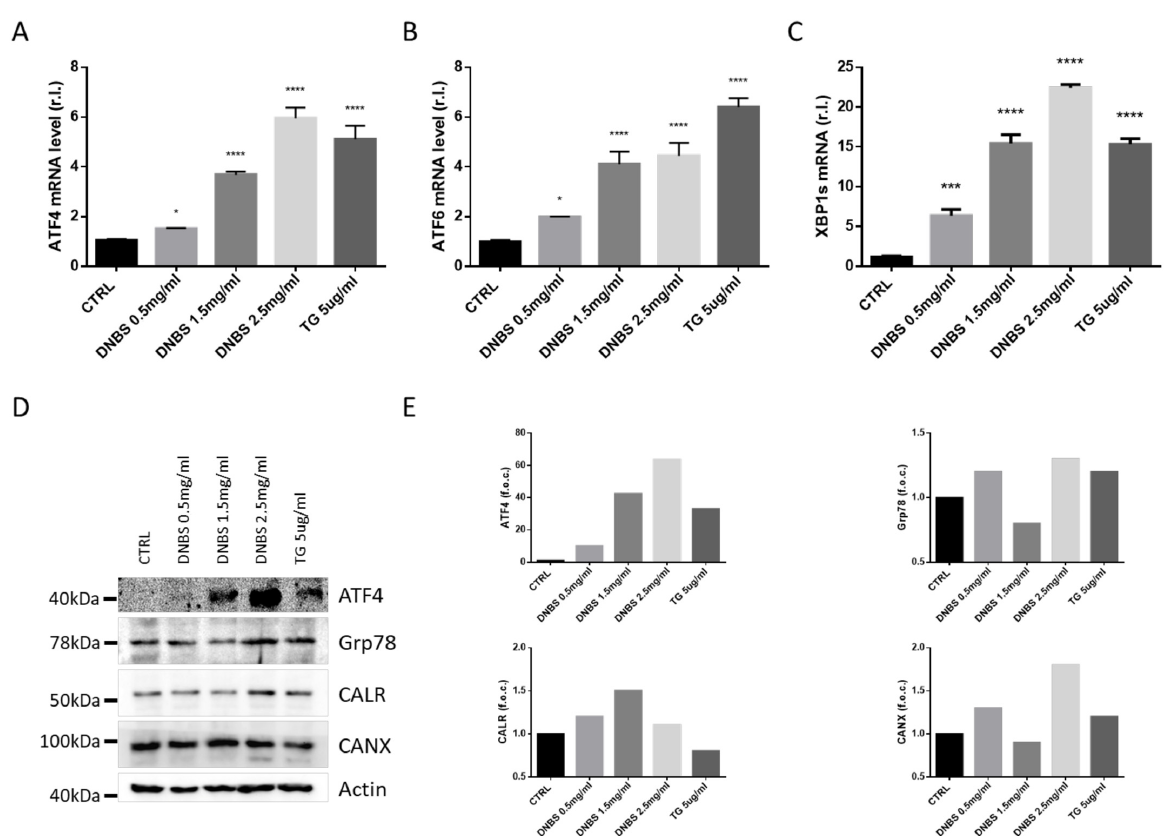
Figure 2. DNBS-induced ER Stress. Tissues were cultivated 5 h in a GEVS and untreated (CTRL) or treated with the indicated concentrations of DNBS, or Thapsigargin (TG), and ATF4 ( A ), ATF6 ( B ), or spliced XBP1 (XBP1s; ( C )) mRNA levels were evaluated by qPCR. The expression levels of other ER stress markers such as ATF4, Grp78, Calreticulin (CANR), or Calnexin (CALX) were evaluated in the same experimental conditions, by western blotting analysis ( D ). ( E ) Densitometric analysis of western blots reported in D. Data is shown as fold change over control (f.o.c.). Each qPCR panel is representative of experiments performed in triplicate. WBs are representative of three independent experiments. Histograms represent mean ± SD of triplicate sample; **** p < 0.0001; *** p < 0.001; * p < 0.05; ns = not significant.